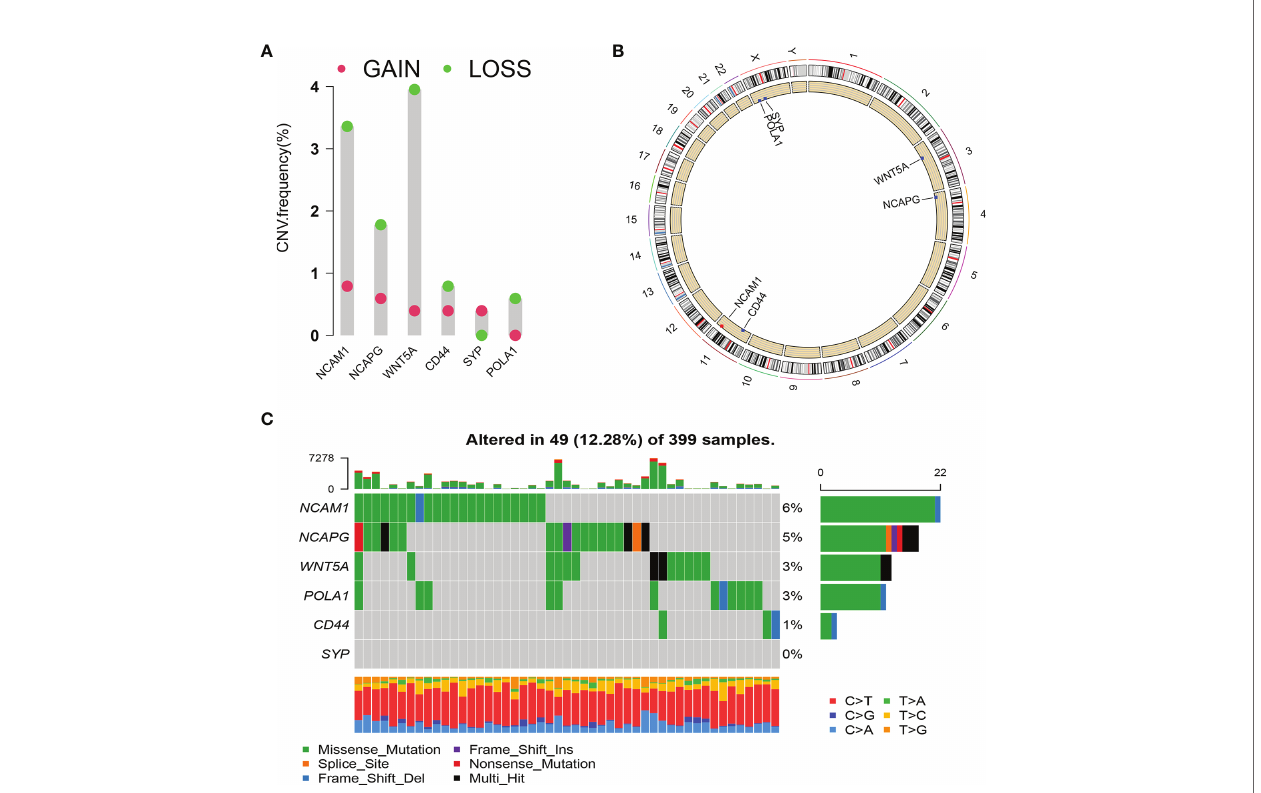
FIGURE 8 | Copy number variation (CNV) and mutation of hub genes. (A) CNV frequency of hub genes. (B) Circle diagram of CNV with hub genes. Red represents CNV gain; blue represents CNV loss. (C) Cascade of core gene